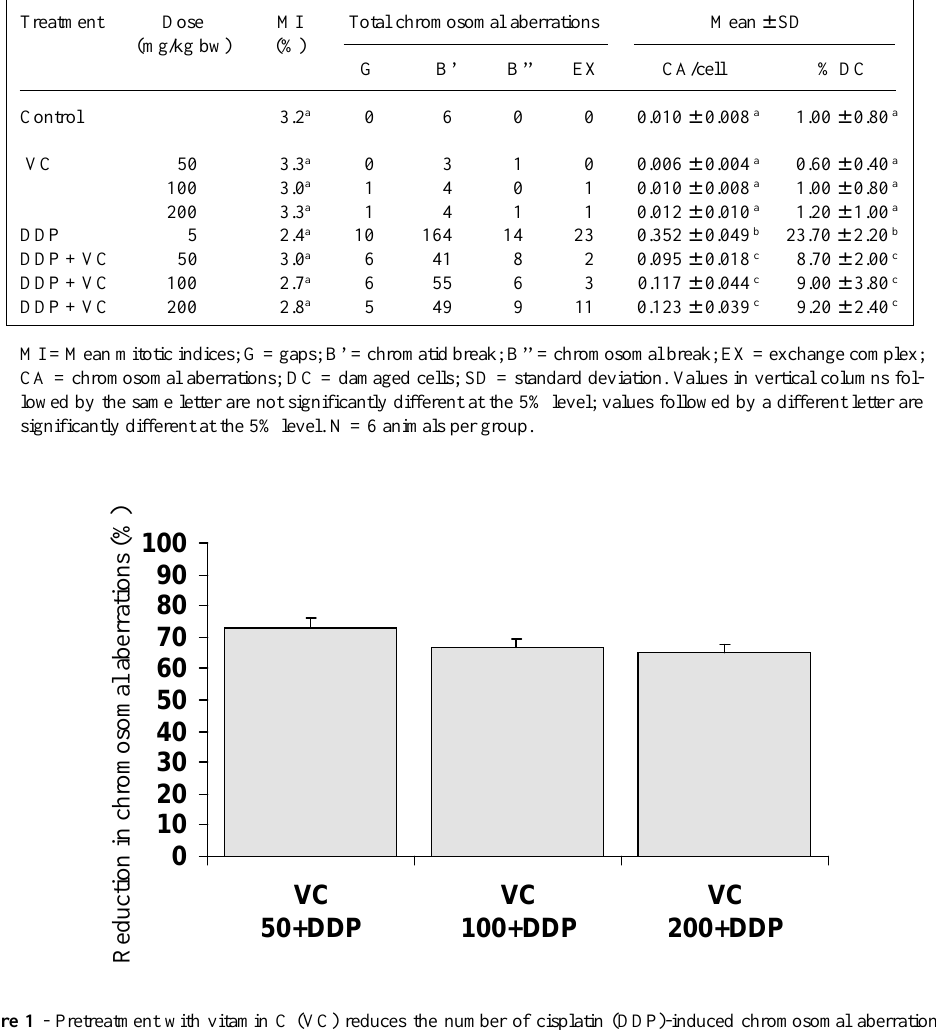
Figure 1 - Pretreatment with vitamin C (VC) reduces the number of cisplatin (DDP)-induced chromosomal aberrations/cell compared to rats treated with cisplatin alone. VC (50, 100 and 200 mg/kg bw) was given by gavage 10 min before DDP (5 mg/ kg bw). Each column is the result from six rats.